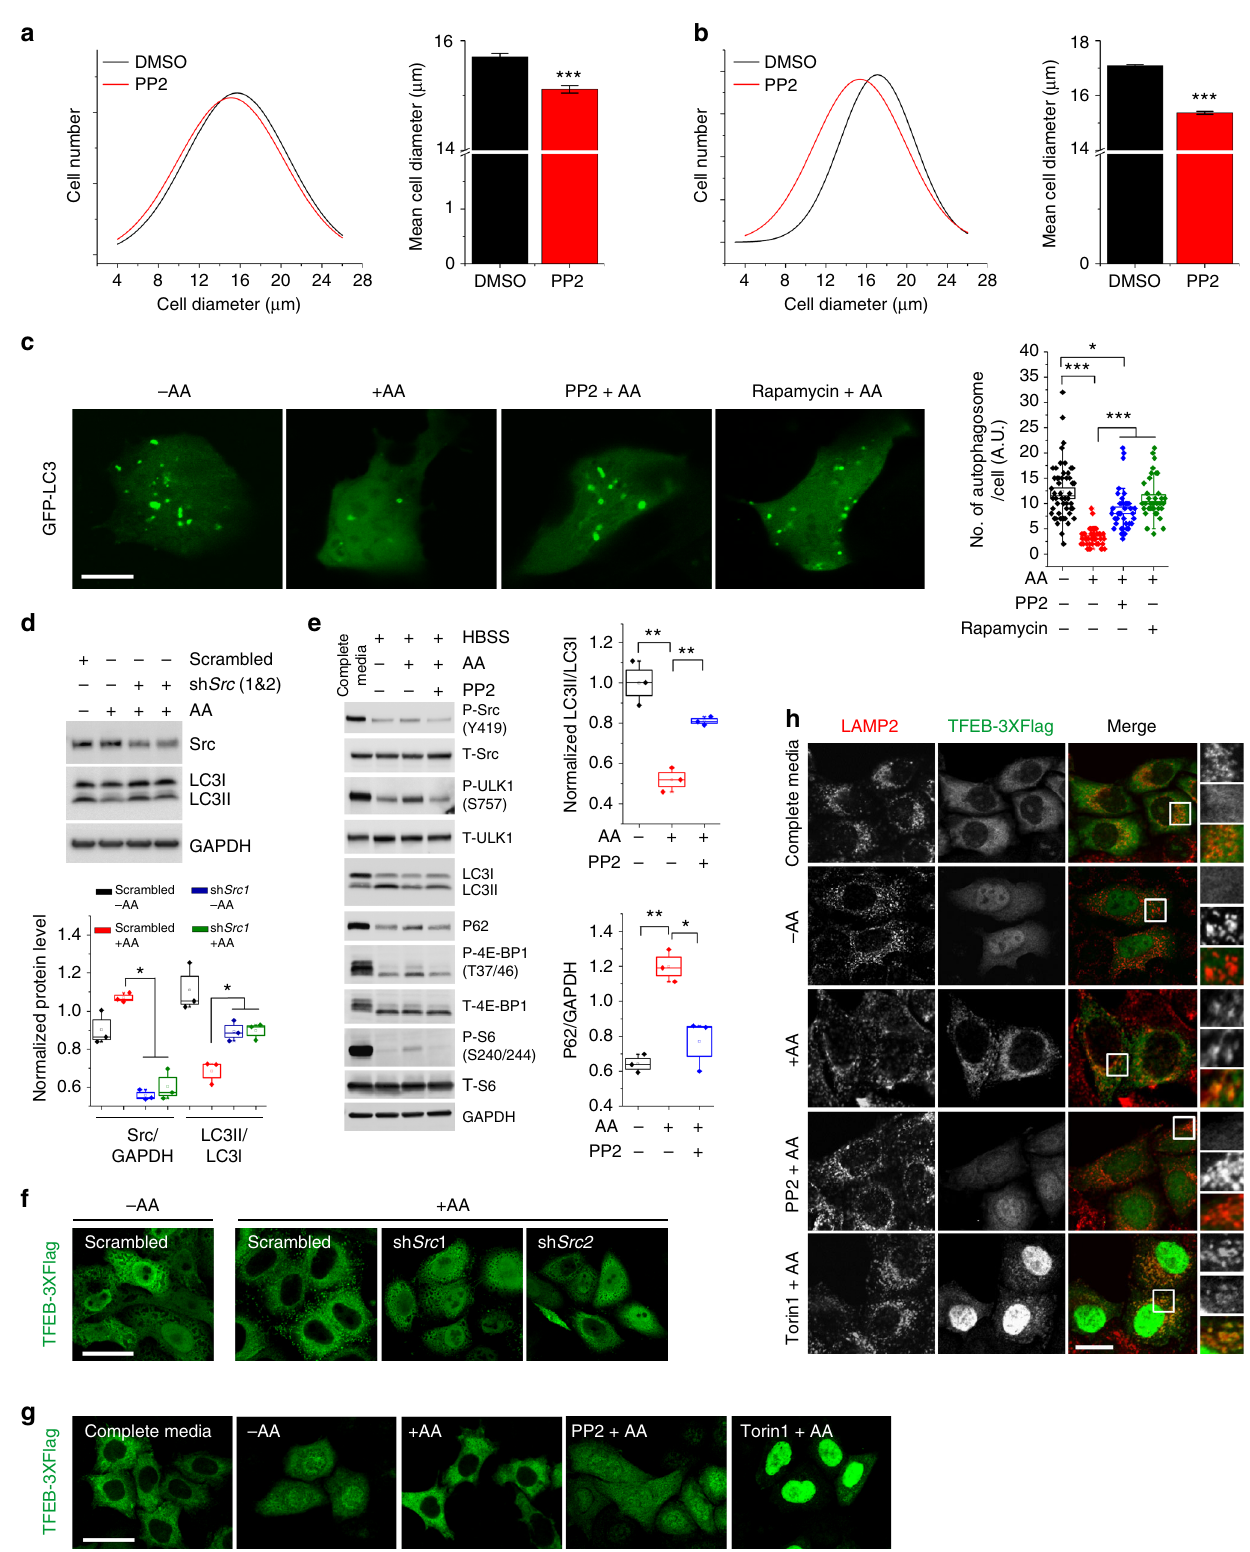
with rotation overnight at 4 °C. 60 μ l of a 50% slurry of protein G-agarose beads (Roche, Basel, Switzerland) was added and incubation continued for 4h at 4°C. Immunoprecipitates were washed three times (7 min each at 4°C) with lysis buffer containing 150 mM NaCl. Immunoprecipitated proteins were denatured by the addition of 20 – 30 μ l of sample buffer (including 2-mercaptoethanol) and boiling for 5min, resolved by 4 – 20% SDS-PAGE (Initrogen, Carlsbad, CA), and analyzed by immunoblotting. For co-transfection experiments, 1.5× 10 6 cells were plated